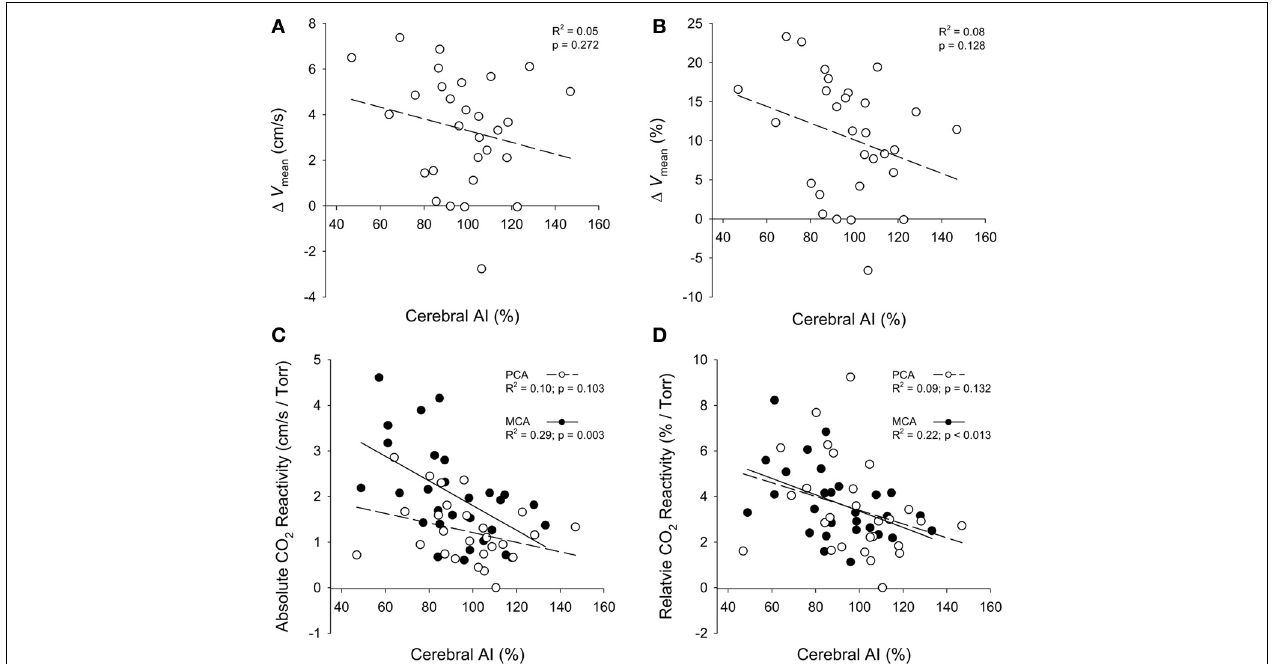
relationships between the absolute (cm/s/Torr) and relative (%/Torr) reactivities to CO 2 for the PCA and MCA with cerebral AI